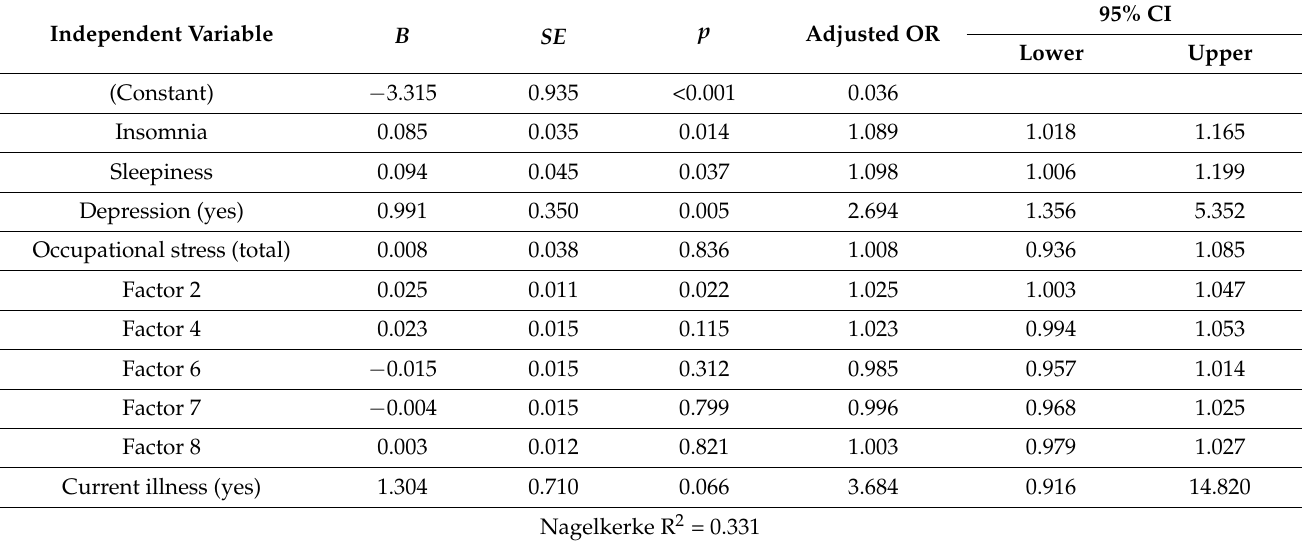
Table 4. Associated factors of fatigue (N =